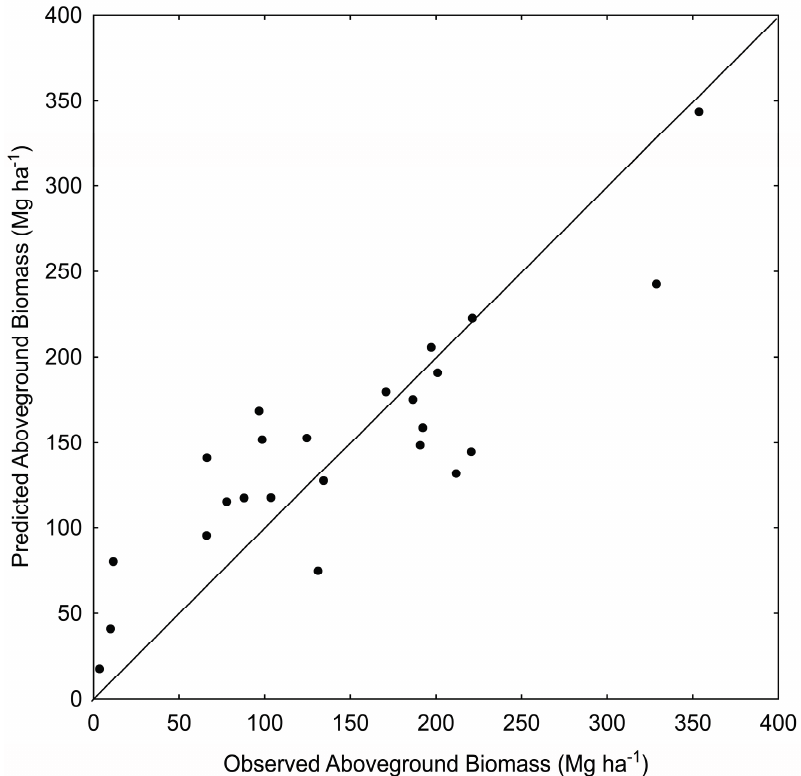
Figure 2. Observed versus predicted biomass values for Landsat TM image texture based biomass map.